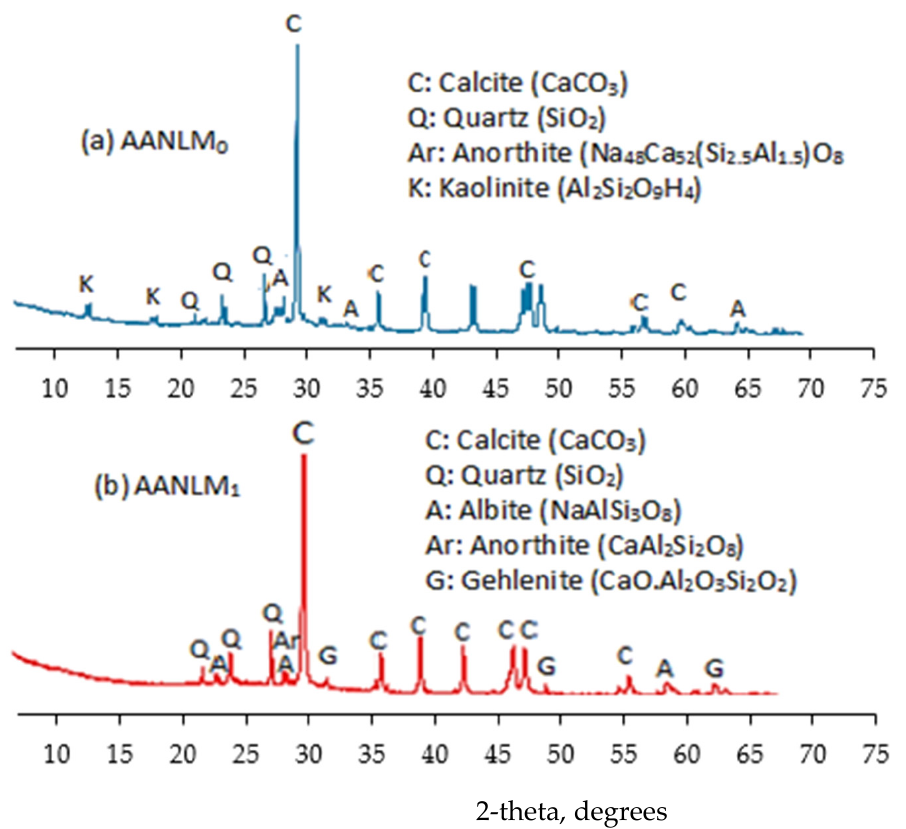
Figure 7. X-ray diffractograms of binder using ( a ) M s = 0 and ( b ) M s = 0.89.